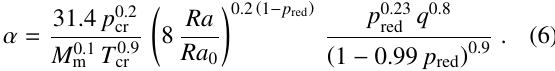
Fig. 1. Apparatus assembly; 1 Heated block, 2 Heating car- tridges, 3 Auxiliary heater, 4 Glass cylinder, 5 Isolating pad, 6 Assembly pad, 7 Plug